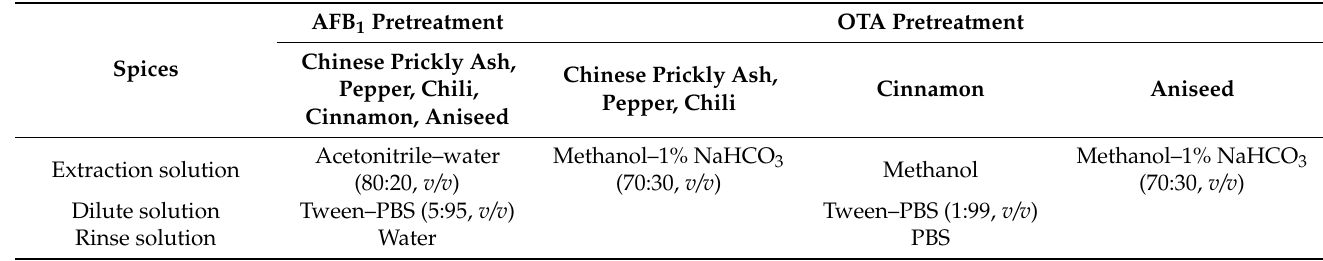
Table 1. Solution used for HPLC